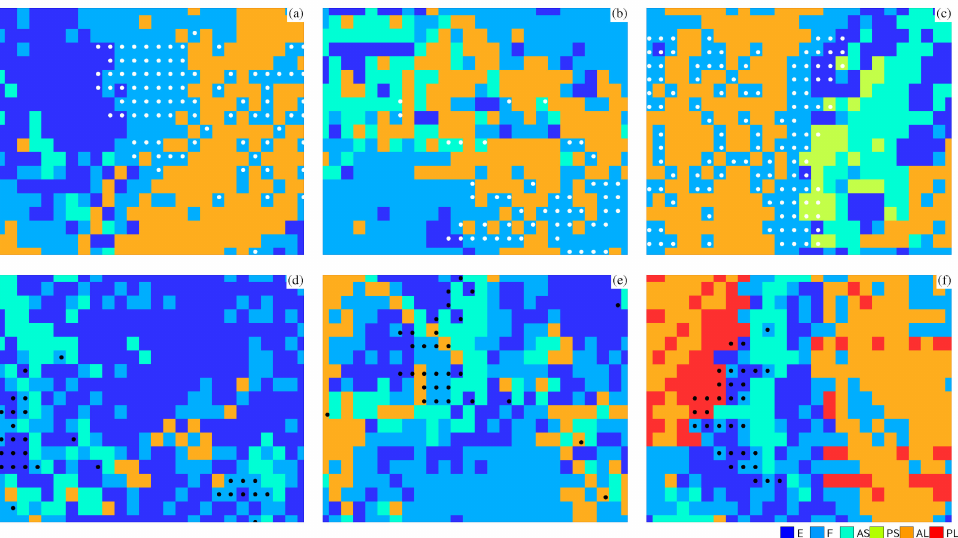
Figure 6. Spatial interactions among the simulated distortions. The white points represent passive layover, while the black points represent passive shadow. ( a – c ) display the passive layover interacting with the foreshortening (“F”), the active shadow (“AS”), and the passive shadow (“PS”); ( d – f ) display the passive shadow interacting with the foreshortening (“F”), the active layover (“AL”), and the passive layover